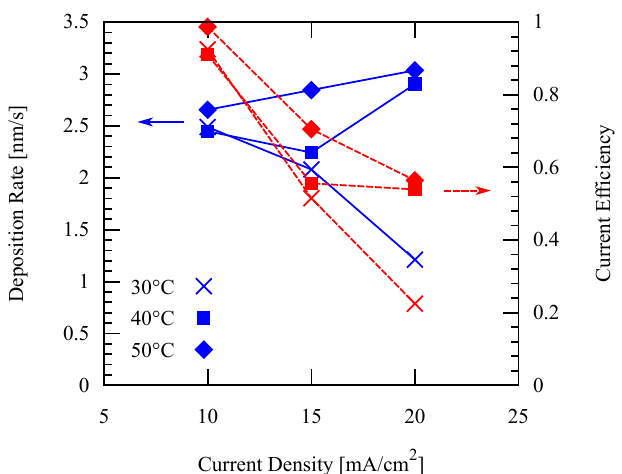
Figure 5. Deposition rate and current efficiency using different current densities at different electrolyte temperatures with 60 s/10 s forward/reverse current duration.